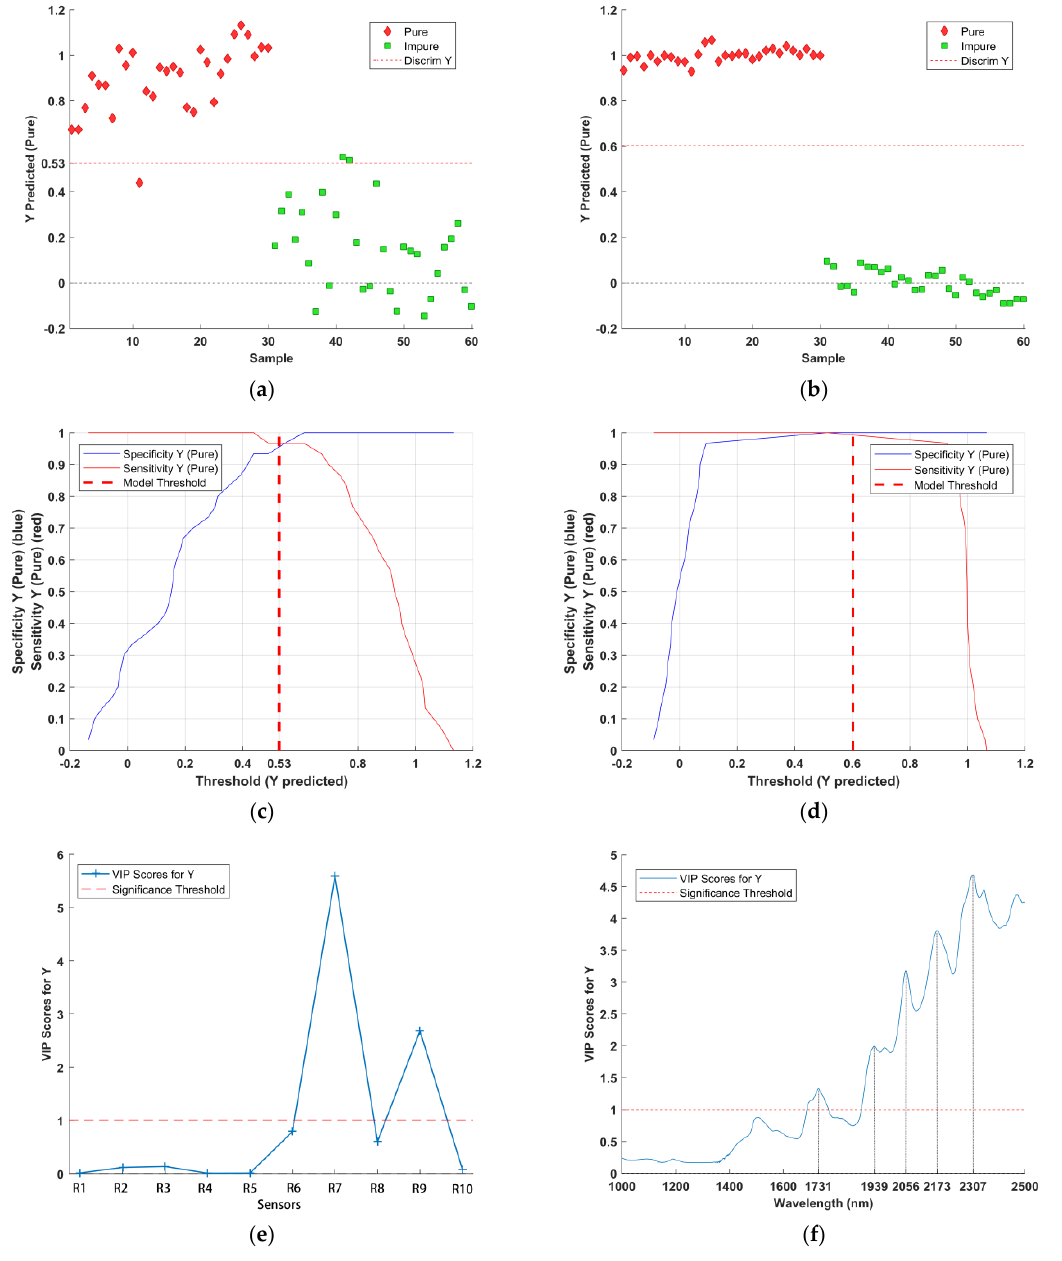
Figure 6. Analysis results of the partial least squares discriminant analysis (PLS–DA) model: Classification results of the validation set for the ( a ) electronic nose data and ( b ) NIRS data. Threshold plots for the PLS–DA models with the ( c ) electronic nose data and ( d ) NIRS data. Variable importance in projection (VIP) plots for the PLS–DA algorithm with the ( e ) electronic nose data and ( f ) NIRS data.